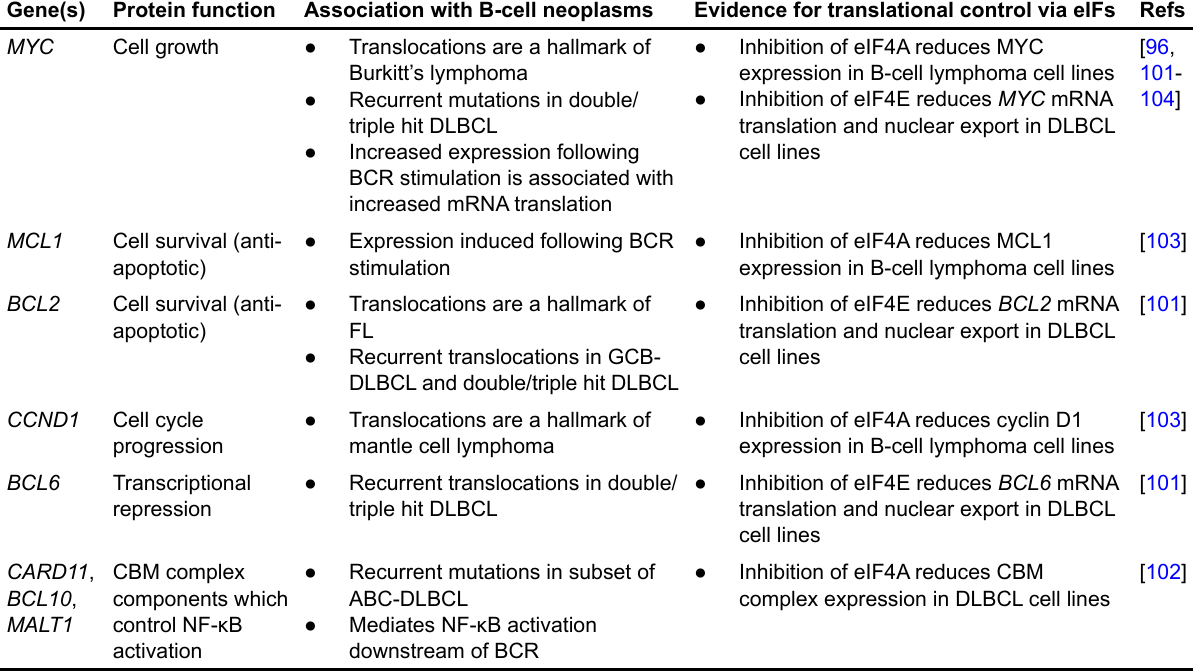
Table 1. Examples of translationally regulated genes with relevance to mature B-cell neoplasms